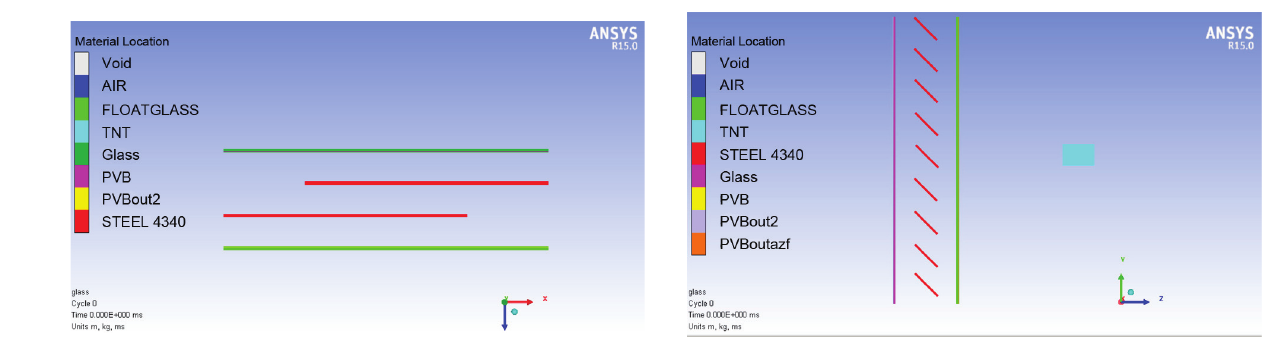
Fig. 5. The plan of two-layer laminated glass with overlapped anti-blast louvered opening